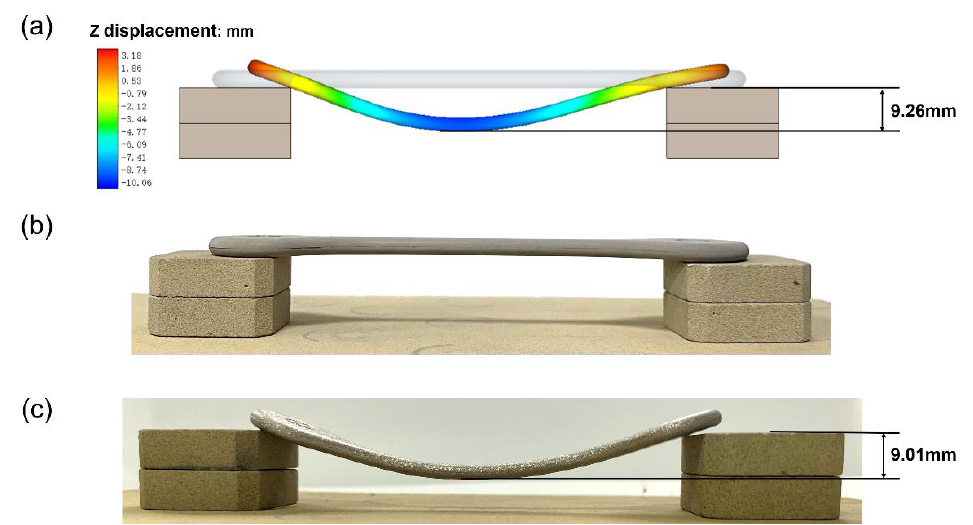
Figure 7. Deformation of elongated specimen for supported Ti-6Al-4V. ( a ) Numerical simulation, ( b ) specimen after thermal debinding, and ( c ) specimen after sintering.